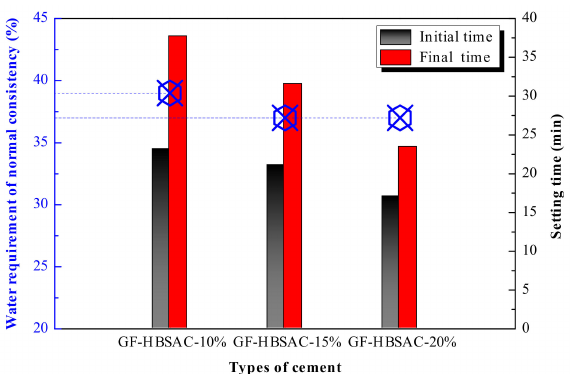
Figure 19. Water requirement of normal consistency and setting time of the Series GF-HBSAC-Y cement.